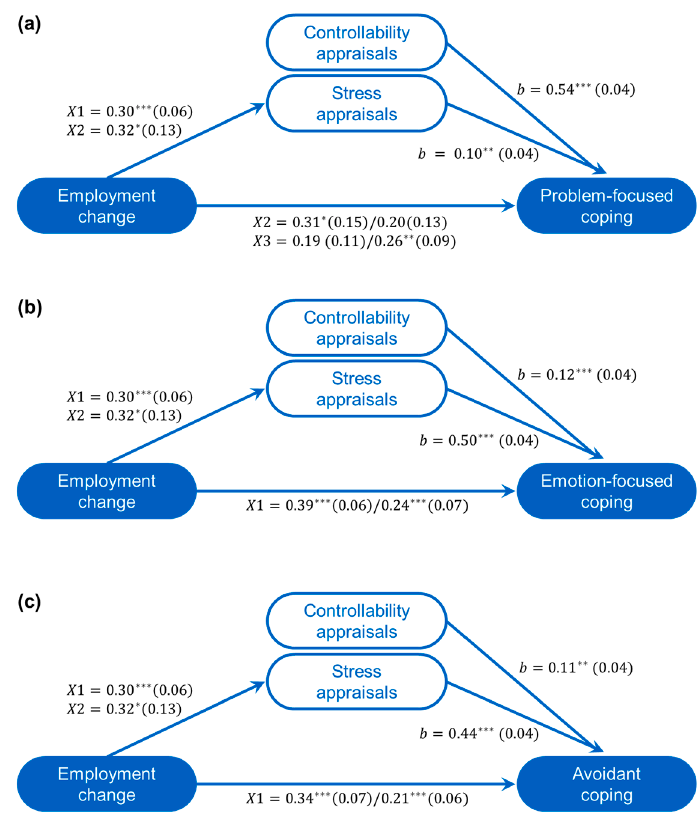
Figure 1. Stress appraisals from change in employment status predicted emotion-focused and avoidant coping strategies. Mediated models (unstandardized coefficients ( se )) of the relationships between change of employment status and problem-focused ( a ), emotion-focused ( b ), and avoidant coping ( c ) as mediated through appraisals of controllability and stress (including total/direct effects between employment change and coping). X1 is the contrast between no change vs. change; X2 is the contrast between more hours vs. reduced hours/laid off; X3 is the contrast between reduced hours and being laid off; b is the unstandardized regression coefficient. * p < 0.05; ** p < 0.01; *** p < 0.001.